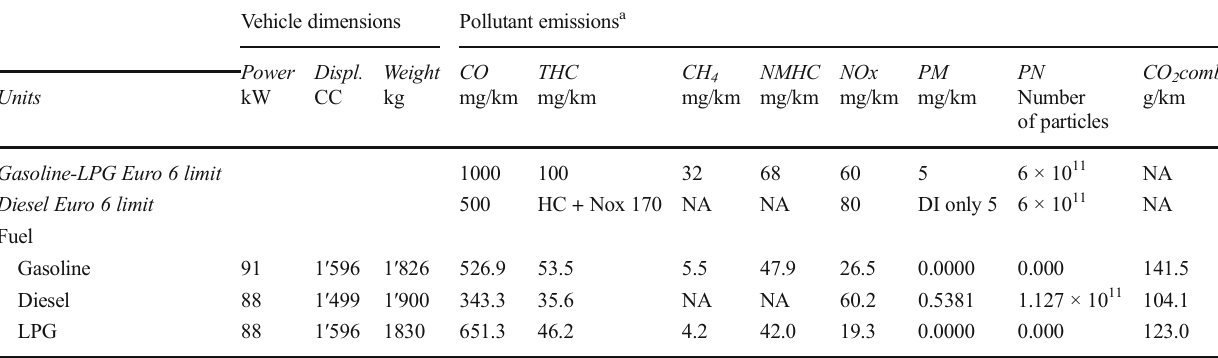
Vehicle tailpipe emissions, Ford Focus, Euro 6, in gasoline, diesel and LPG bi-fuel Vehicle dimensions